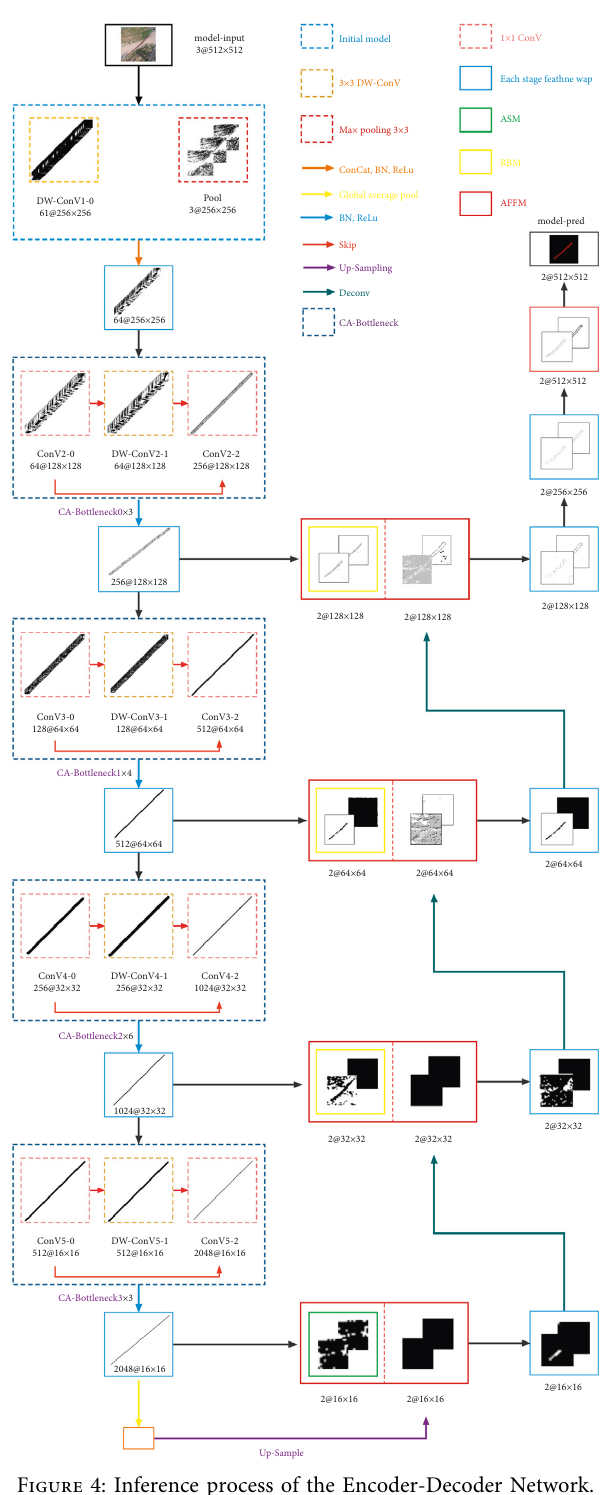
Figure 4: Inference process of the Encoder-Decoder